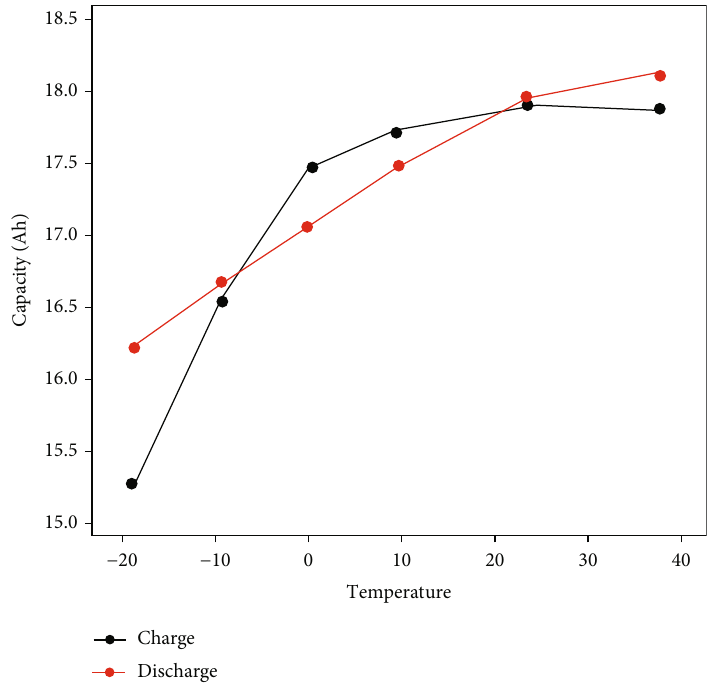
Figure 6: Change trend of charge and discharge capacity with ambient